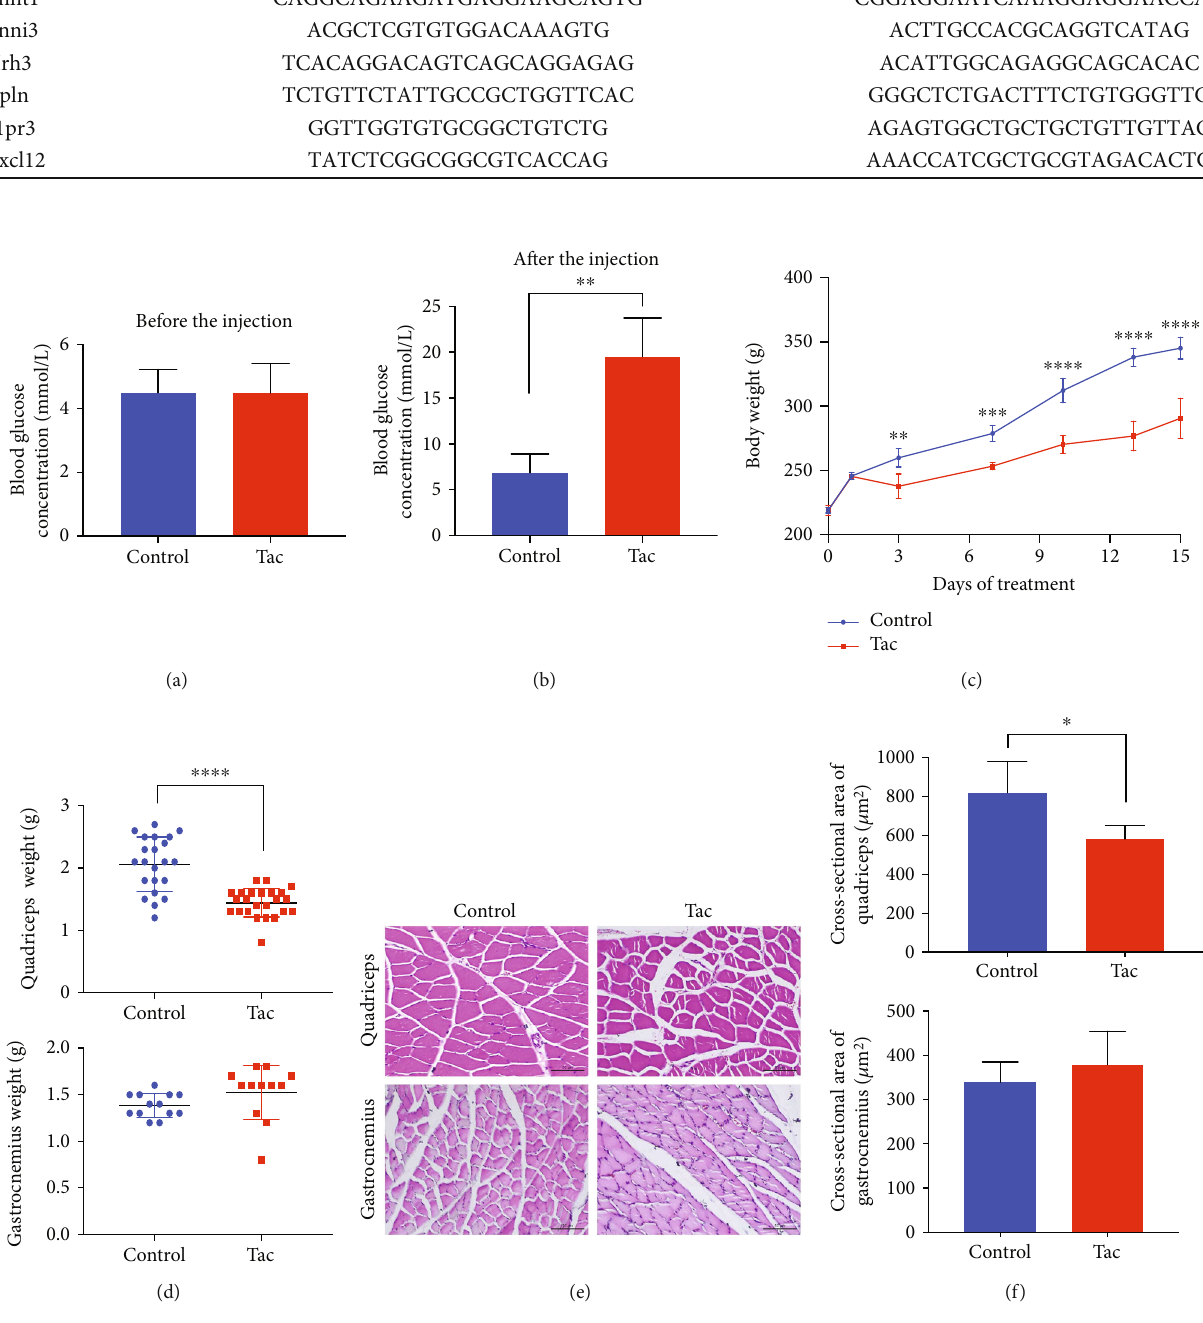
Figure 1: Skeletal muscle atrophy in rats with posttransplantation diabetes mellitus (PTDM). Blood glucose concentrations before and after the injection (a, b). Body weight of the rats (c). Wet weight of quadriceps and gastrocnemius (d). Cross-section area of quadriceps and gastrocnemius stained with hematoxylin and eosin (e). The data of cross-section area (f). Scale bars represent 50 μ m. Data are means ± SD . ∗ p < 0 : 05 , ∗∗ p < 0 : 01 , ∗∗∗∗ p < 0 : 0001